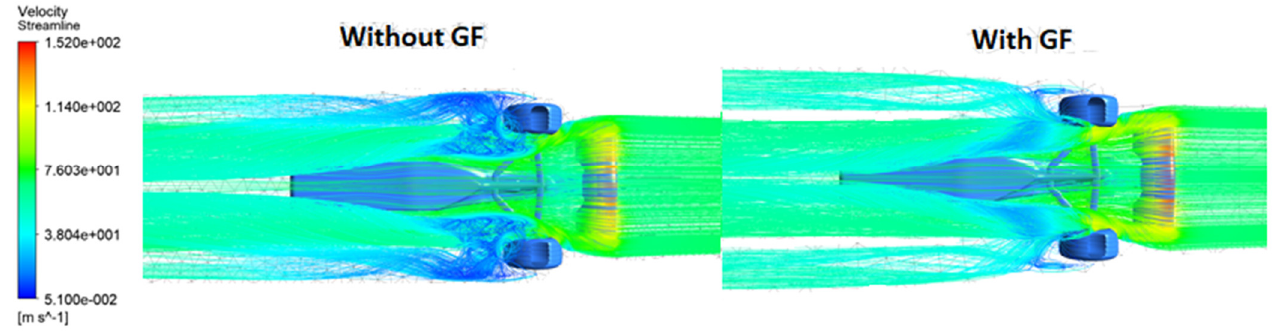
Figure 13. Comparison of the streamlines below the vehicle between the case with and without GF. Figure 14 shows the streamlines pattern on a transversal plane close to the endplates (plane y 4 ) where the flow without a GF (left) is slower close to ground and gives rise to a large recirculation area due to interaction with the tire. The configuration with the GF, as previously discussed, has higher velocity close to ground and the above recirculation area is absent; the flow is deflected upward with a positive interaction with the suspensions, as previously discussed. However, in this last case, the wake of the car is wider (streamlines deflection) thus giving more overall drag, but also beneficial effects on the tire, as previously claimed.